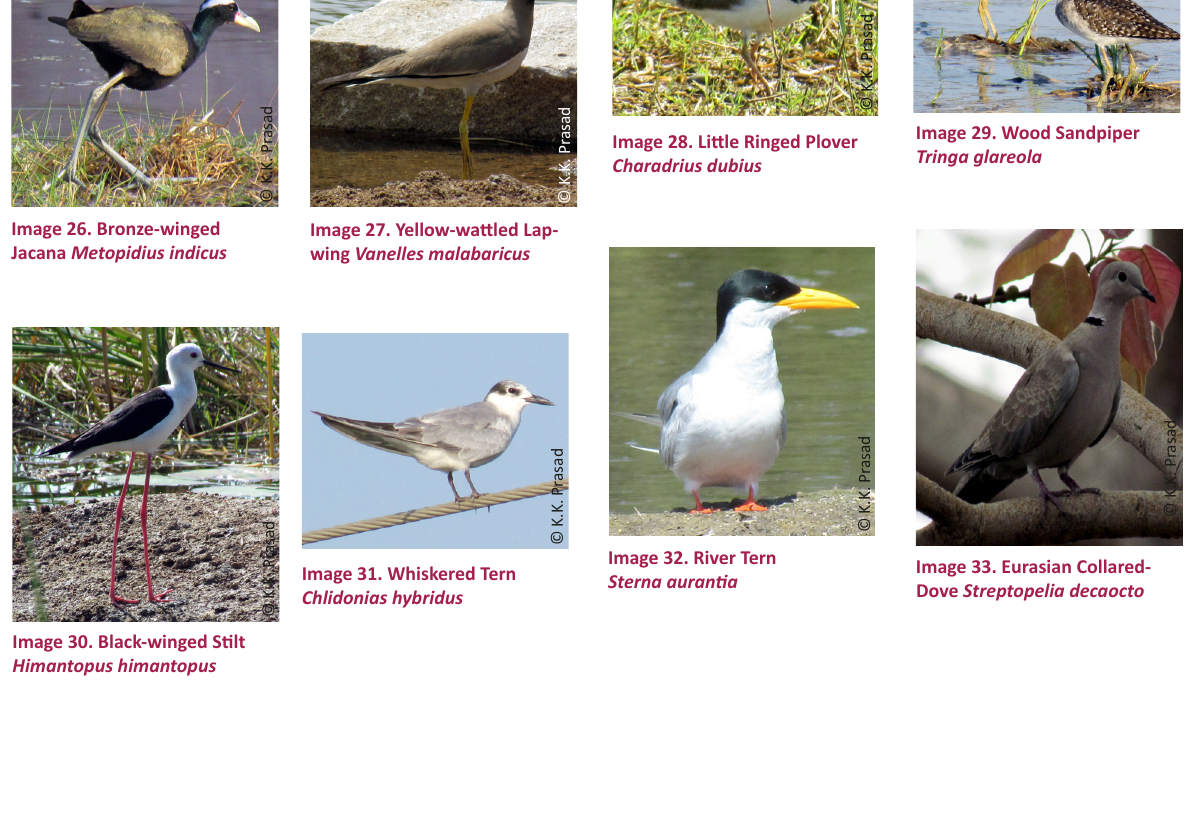
Image 22. White-breasted Wa- terhen Amauronis phoenicurus